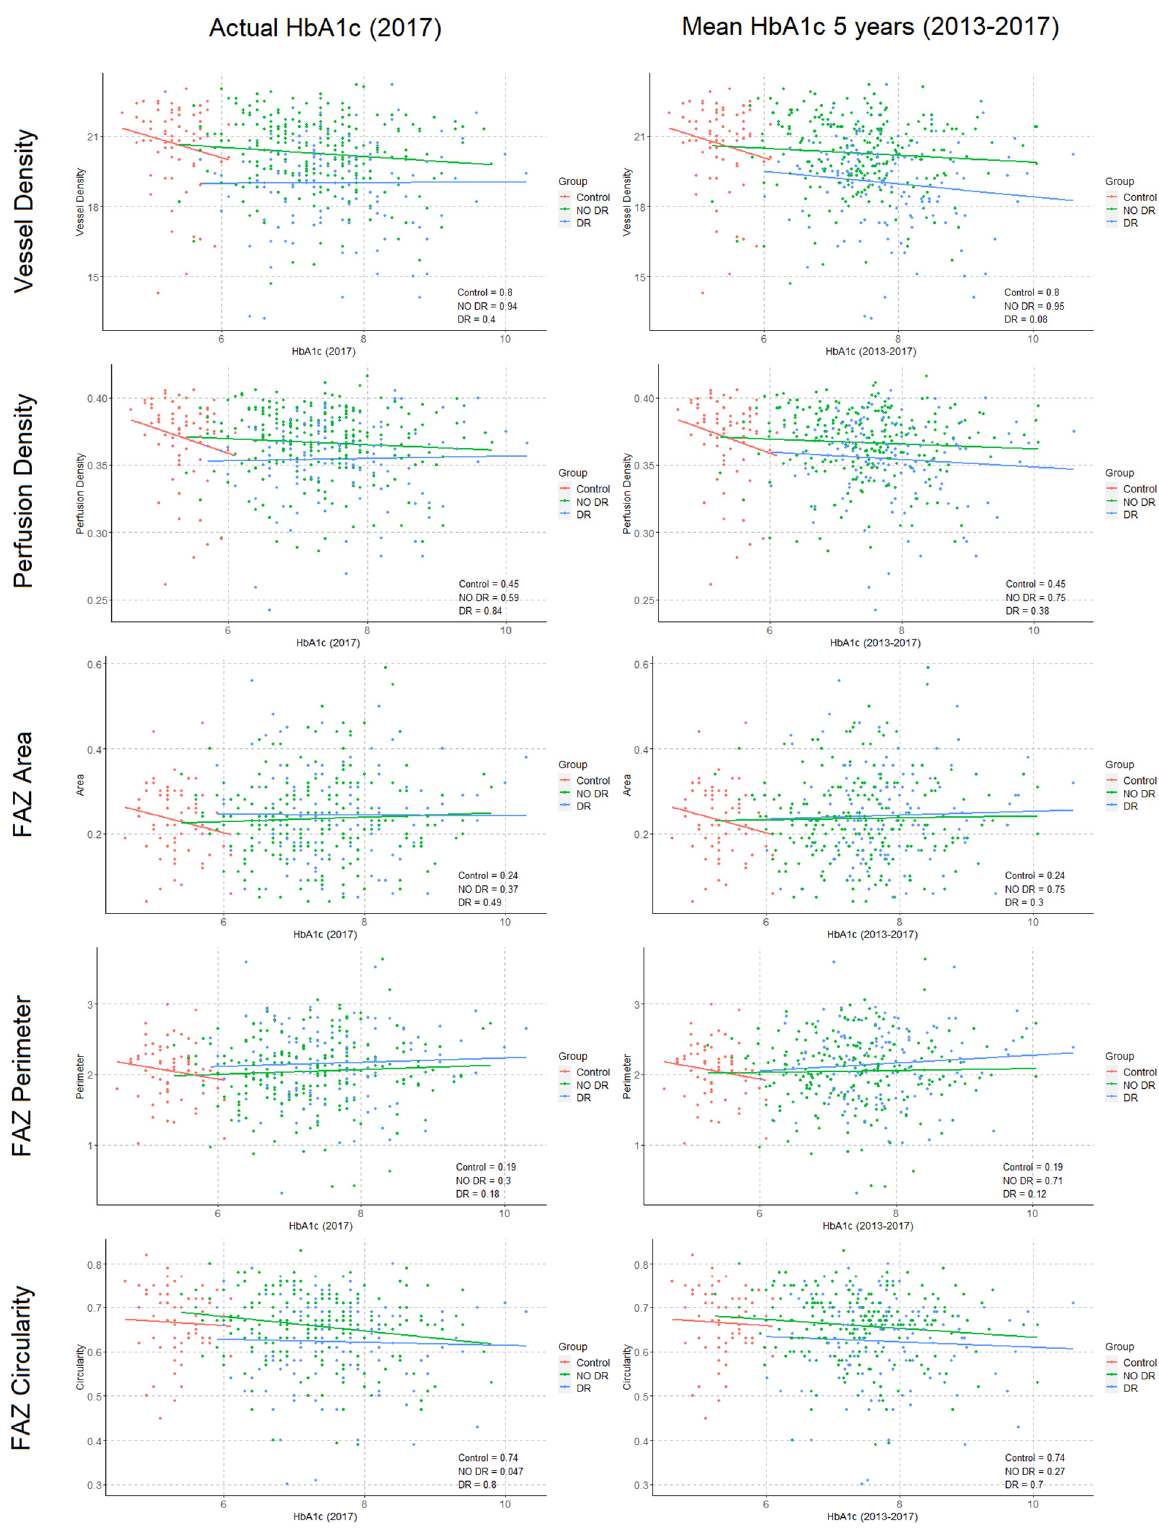
Figure 5. Correlations between glycated haemoglobin (HbA1c) levels and optical coherence tomography angiography (OCTA) parameters in study subgroups. Left : OCTA parameters and actual HbA1c level at the retinal imaging timepoint (2017). Right : OCTA parameters and Mean HbA1c calculated from previous 5 years timepoints (2013 to 2017). (Numerical values represent the p -value of correlations, p -values are adjusted by age, sex, signal strength index, diabetes mellitus duration, and axial